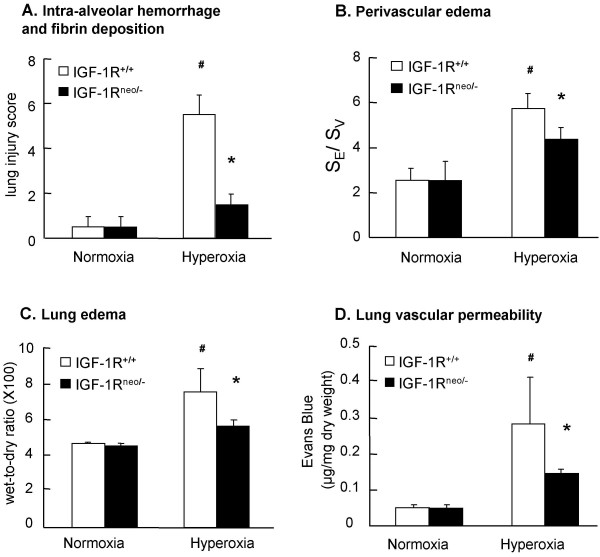
Hyperoxia-induced lung injury, lung edema and vascular permeability. Parameters of lung damage were considered under basal conditions and following hyperoxia. (A) Lung injury scores from IGF-1R+/+ (n = 4) and IGF-1Rneo/- (n = 4) mice under basal conditions (normoxia) and under hyperoxia. A cumulative score was based on evaluation of hemorrhage and intraalveolar deposition (6 random sections per lung). (B) Quantitated perivascular edema from IGF-1R+/+ (n = 4) and IGF-1Rneo/- (n = 4) mice under basal conditions (normoxia) and under hyperoxia. Surface of perivascular edema was reported to the surface of the vessel, and noted SE/SV (5 selected sections per lung). (C) Lung edema was determined as mean values (± SD) of wet-to-dry lung weight ratio under basal conditions (normoxia) in IGF-1R+/+ (n = 4) and IGF-1Rneo/- (n = 4) mice, and under hyperoxia in IGF-1R+/+ (n = 7) and IGF-1Rneo/- (n = 8) mice. (D) Evans Blue dye extravasation was assessed as mean values (± SD) in IGF-1R+/+ (n = 13) and IGF-1Rneo/- (n = 11) mice. Crosses indicate significant differences between hyperoxic and normoxic values in IGF-1R+/+ mice, and asterisks indicate significant differences between IGF-1R+/+ and IGF-1Rneo/- mice under hyperoxic conditions; P < 0.05.